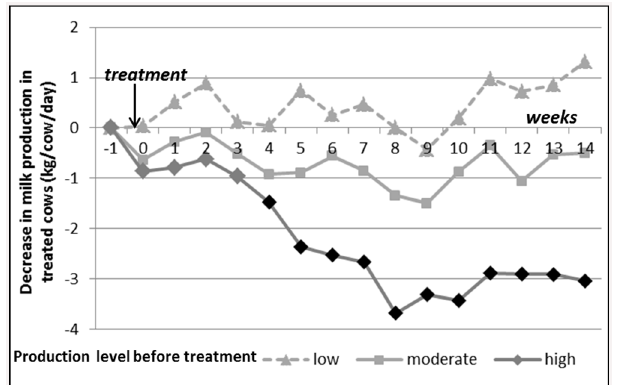
Fig 2. Evolution of the treated cows ’ milk production over time in comparison with control cows (G i s) according to the pre-treatment production level (corrected for parity and days in milk). Week 0 = week of treatment, the first day of week 0 is the day of treatment. Black dots on the curve indicate that the corresponding negative G i are significantly different from zero, adjusted p-value < 0.05: the drop in milk production for treated cows is significant during these weeks). See Table 2 for the number of treated cows and control cows per